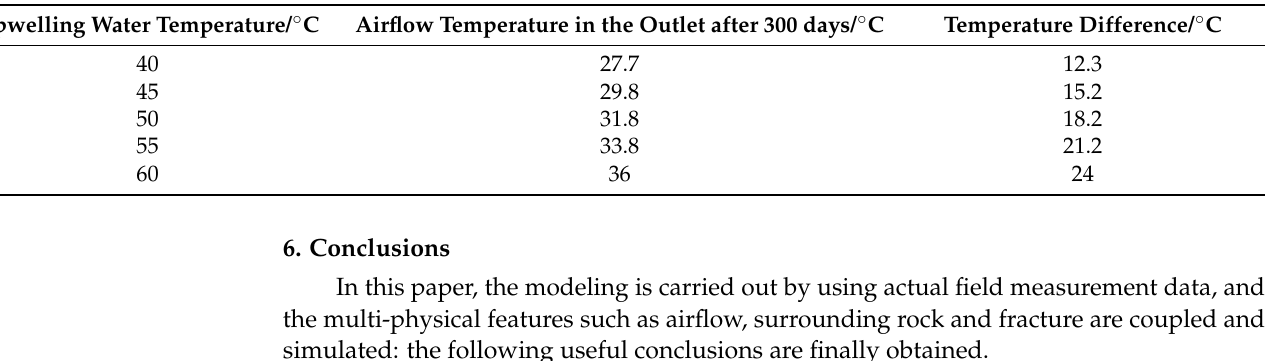
Figure 16. The airflow temperature in the outlet of the roadway at different temperatures and the same pressure. Table 6. Temperature difference of airflow